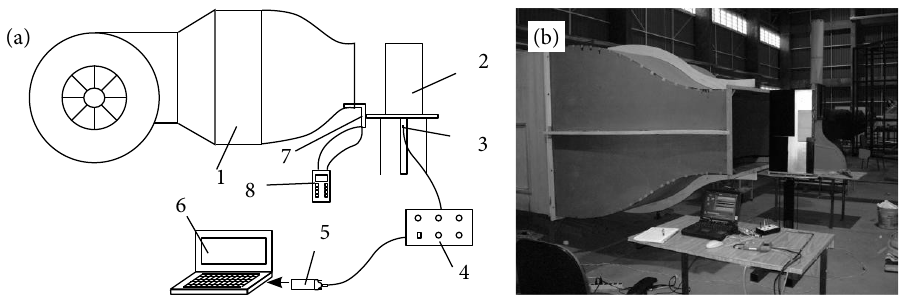
Figure 10. Experimental set for flutter characteristics determination scheme (a) and its picture